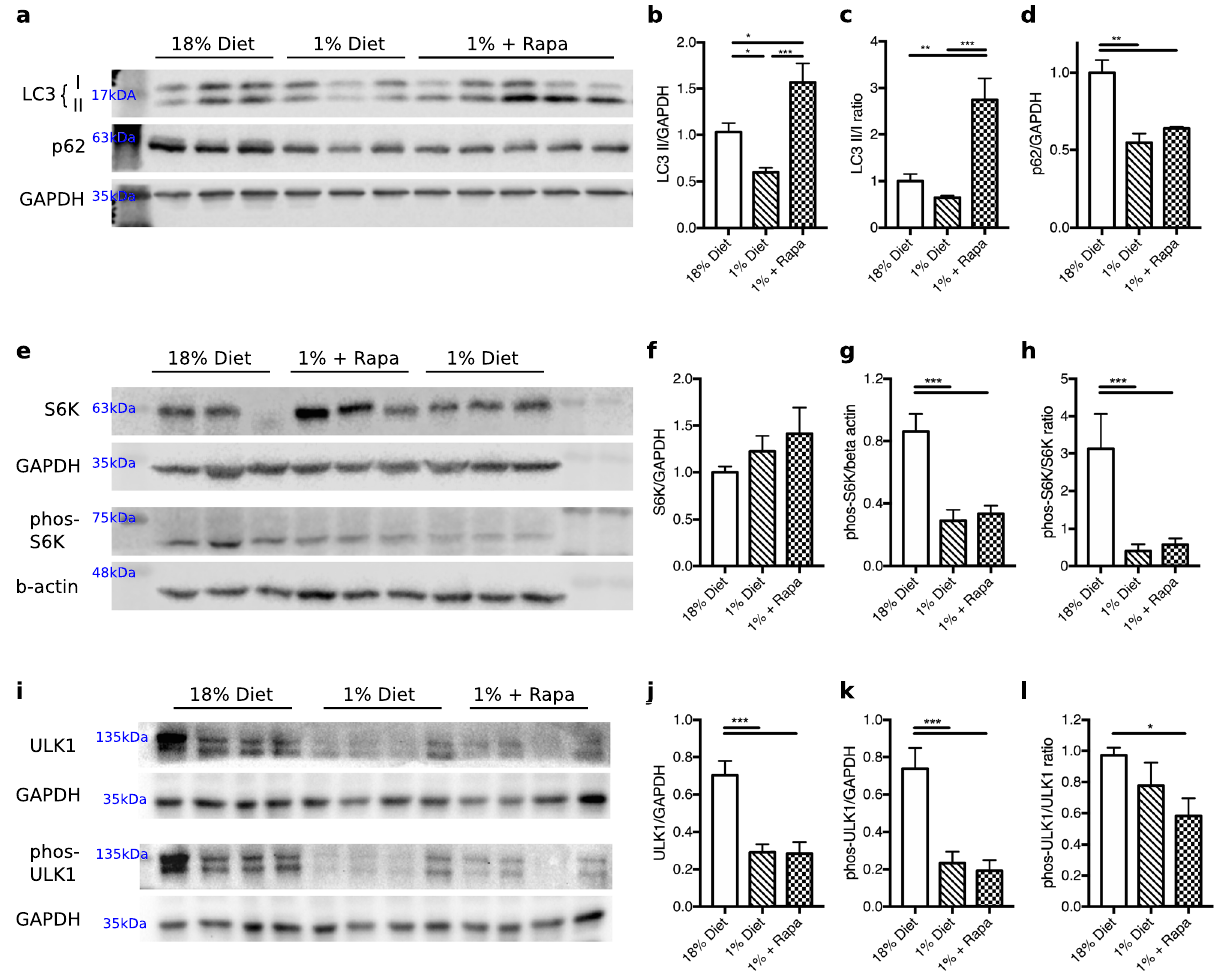
GAPDH. ( c ) LC3-II to I ratio. ( d ) p62/GAPDH. ( e ) Western blots S6K, GAPDH, phos-S6K, beta-actin. Western blot quantification of and shown as a relative expression to 18% control diet ( f ) S6K/GAPDH. ( g ) phos-S6K. ( h ) phos-S6K/S6K ratio. ( i ) Western blots ULK1, GAPDH, phos-ULK1 ( j ) ULK1/GAPDH. ( k ) phos-ULK1/ GAPDH. ( l ) phos-ULK1:ULK ratio. The westerns were cut prior to incubation with the primary antibodies,